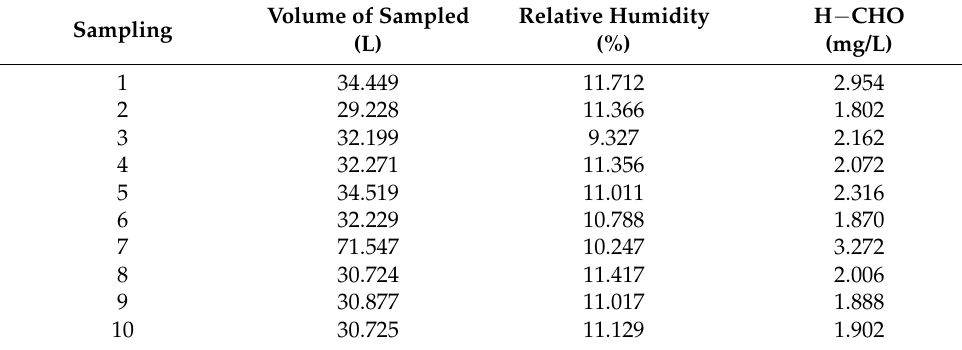
Table 13. Values of the sampling conducted by the Lab. RSE with acid solution and analysis by HPLC; the solutions were complexed the same evening as the sampling of the Second